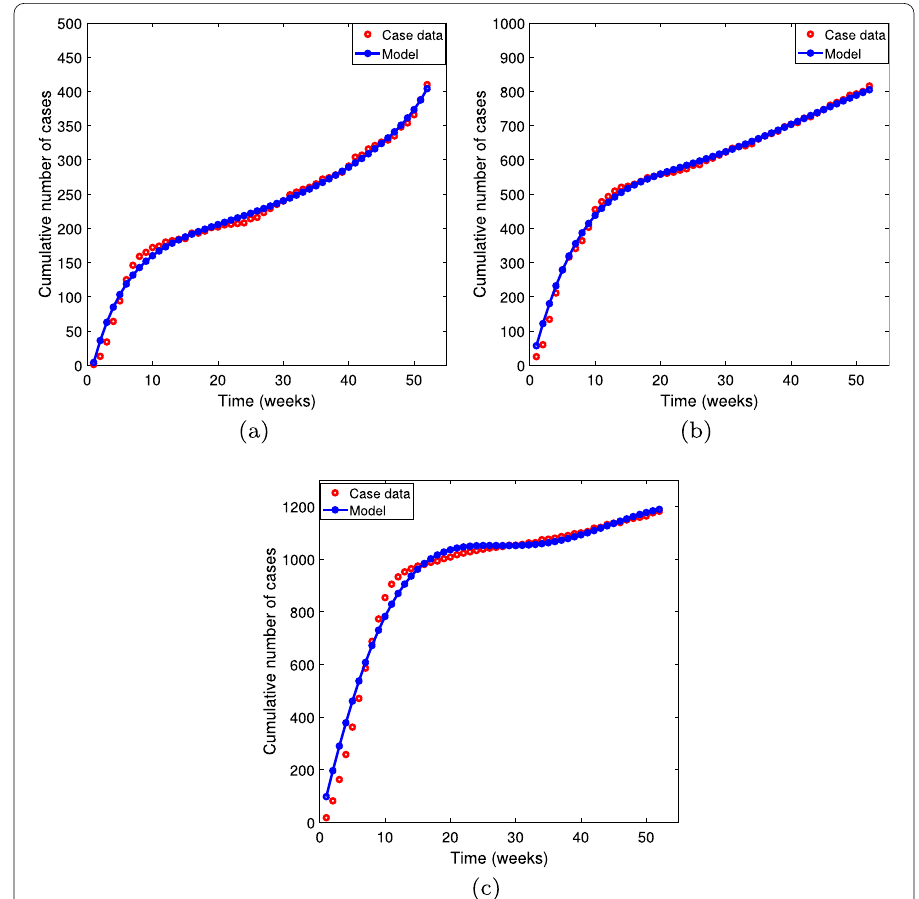
Fig. 2 Data fitting of the Lassa fever model (1) using a 2018 cumulative cases; b 2019 cumulative cases; c 2020 cumulative